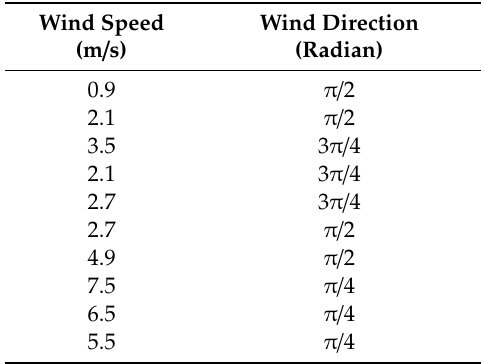
Table 1. Wind speed and direction data for the algorithms.